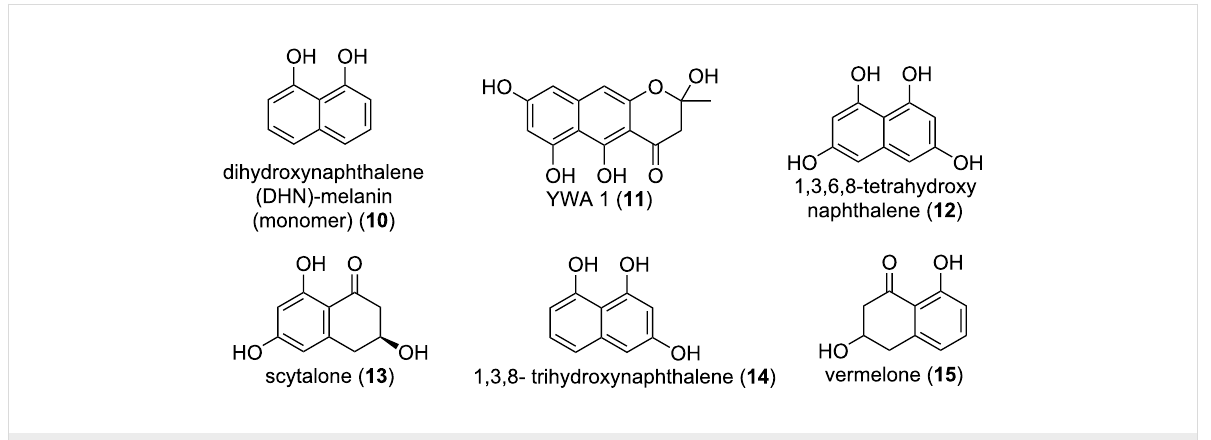
Figure 5: Intermediates of the DHN-melanin biosynthesis in Aspergillus fumigatus .